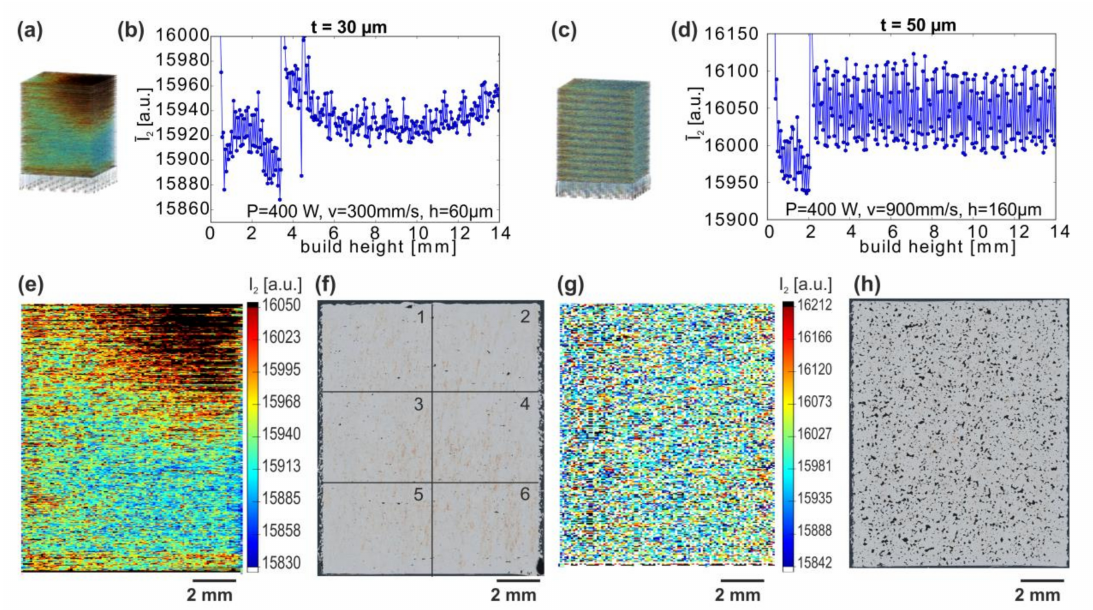
Figure 9. 3D visualization of MPM data (¯I 2 ; ( a , c )), corresponding layer-averaged plots over the build height( b , d )andMPMslices( e , g )versuscorrespondinglightopticalmicroscopysections( f , h )forselected cuboidswhichweremanufacturedwithdi ff erentprocessparameters(t = 30 µ m, P = 400W,v = 300 mm / s, h = 60 µ m and t = 50 µ m, P = 400 W, v = 900 mm / s, h = 160 µ m). Both specimens (baseplate positions marked in Figure 2a,b with red boxes) show high scattering (Figure 8c,d, marked A and B). The LOM image ( f ) is divided into 6 areas for further analysis.